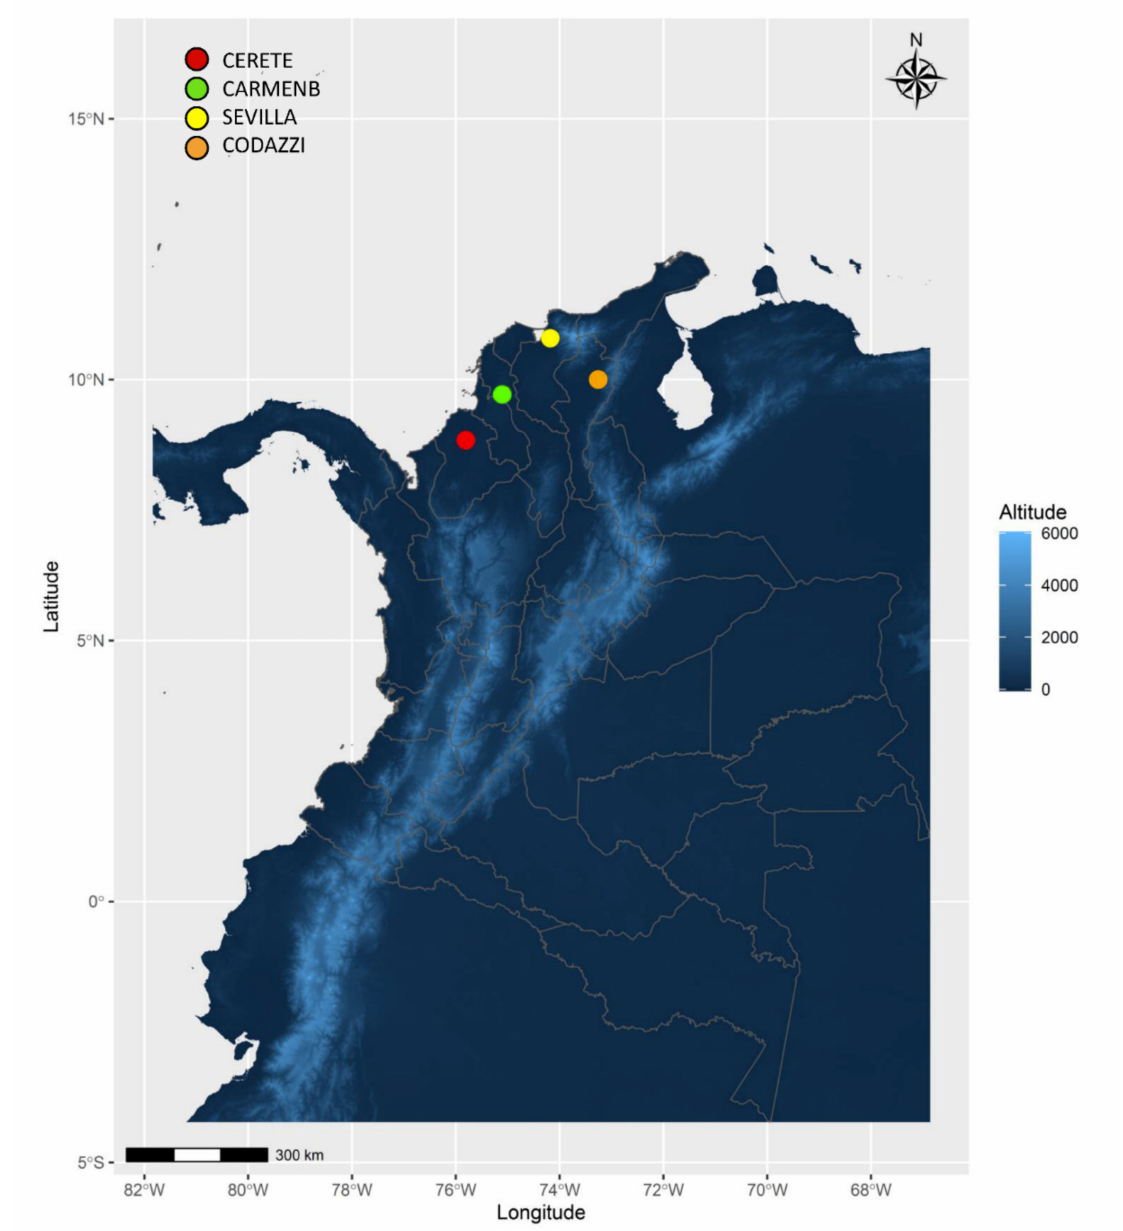
Figure 1. Study area showing locations with geographical and altitudinal